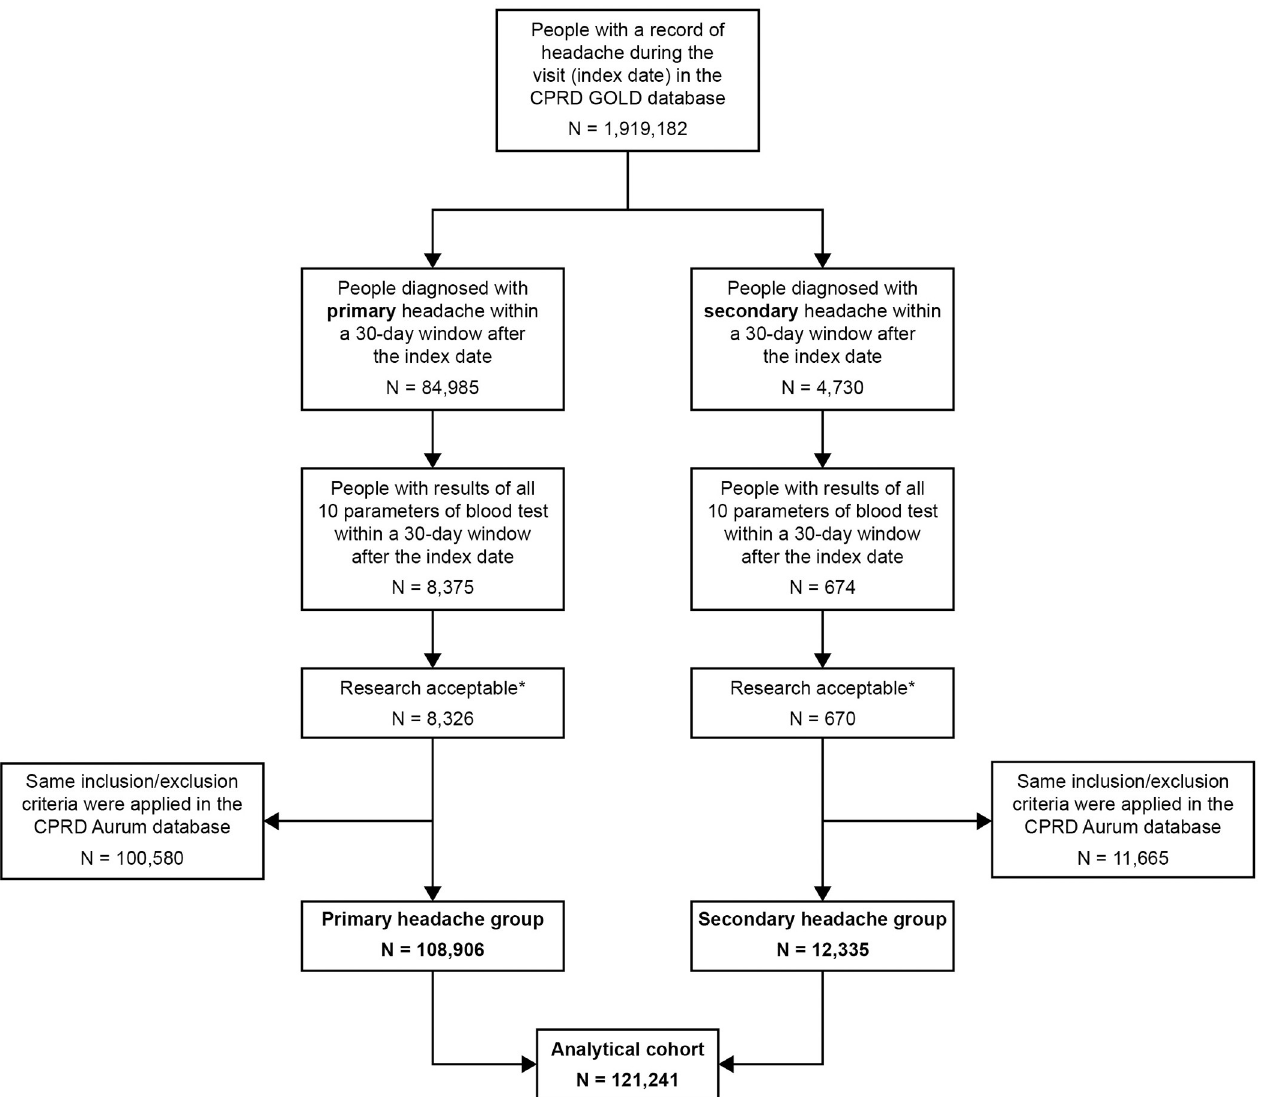
Fig 1. Patient flow and determination of the analytical cohort. � Patient data flagged as “research acceptable” by CPRD. Two consultation types ("follow-up/ routine visit" and "mail from patient") occurring on the index date were removed from the data set. CPRD, Clinical Practice Research Datalink.